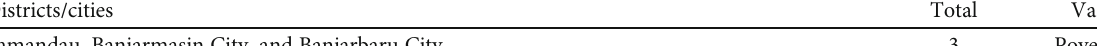
Table 5: Grouping of the districts/cities based on the signi fi cant variables. Districts/cities